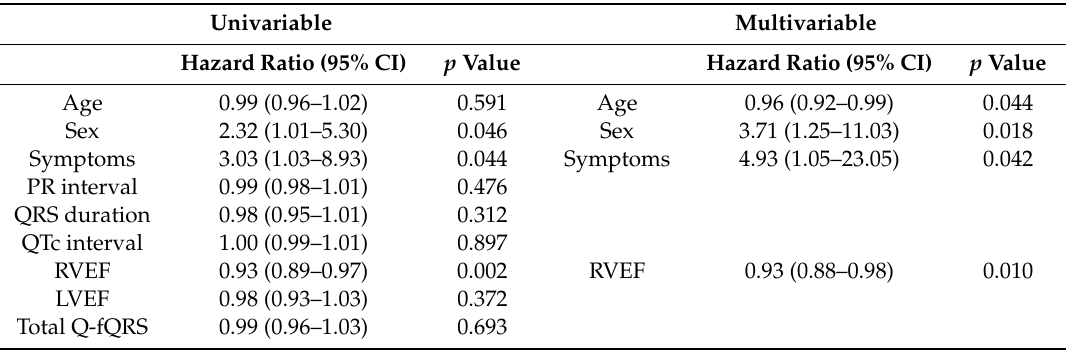
Table 4. Univariable and multivariable analysis of SVA risk in genotype positive definite ACM patients without prior